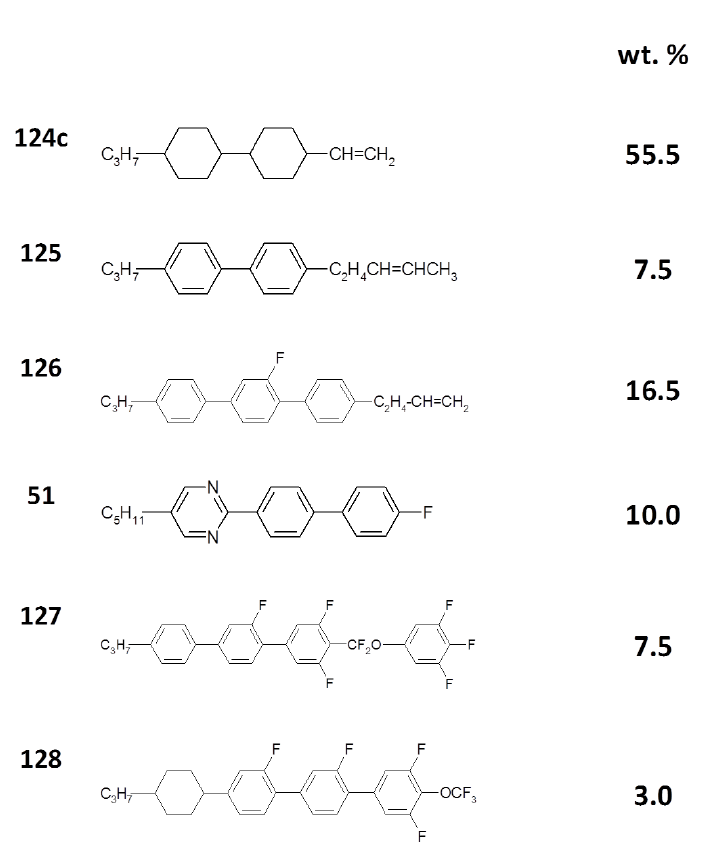
Figure 12. Composition of mixture with low rotational viscosity γ . The mixture properties: clearing point 75 °C, d = 3.18, d ·  n = 0.412,  n = 0.1297,  = 3.6,  = 48 mPa·s, t = 0.85 ms, t = 3.17 ms, t + t = 4.0 ms, V = 2.35 V, V = 2.75 V, V = 3.34 V on off on off 10 50 90